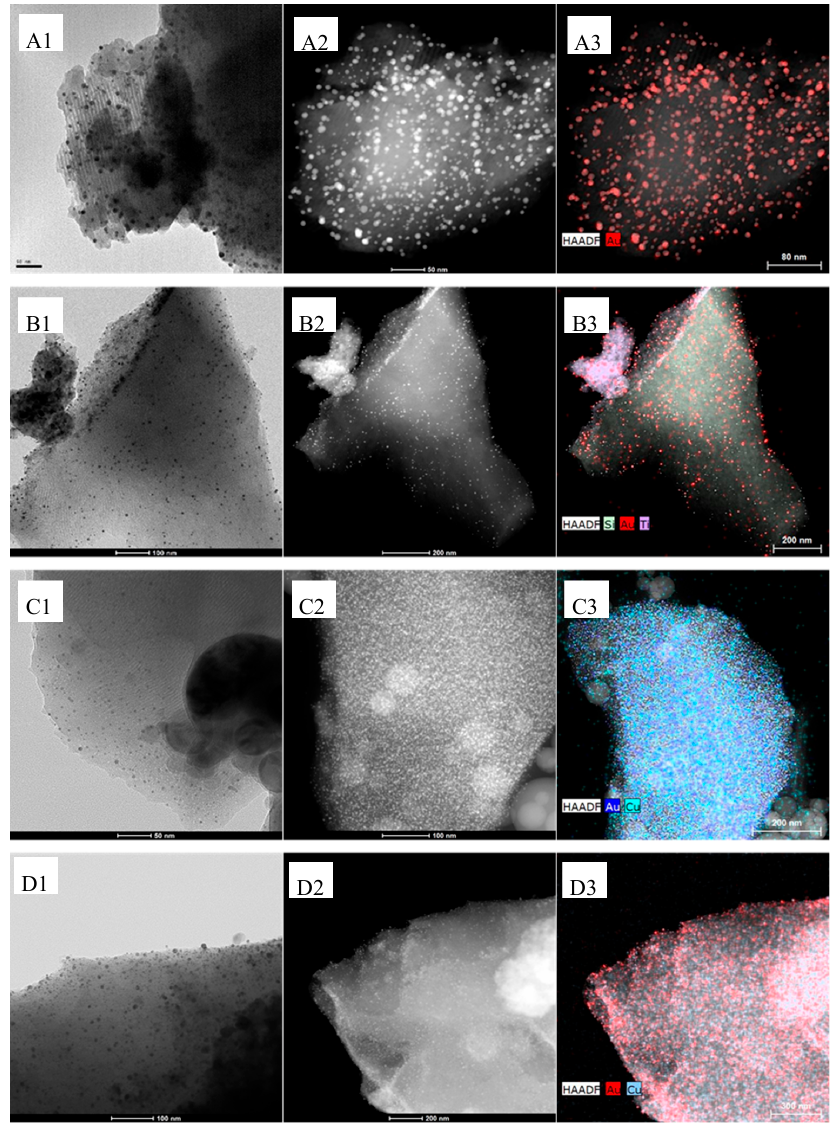
Figure 3. HR-TEM results corresponding to ( A ) Au/Si, ( B ) Au/TiSi, ( C ) AuCu/Si, and ( D ) AuCu/TiSi.